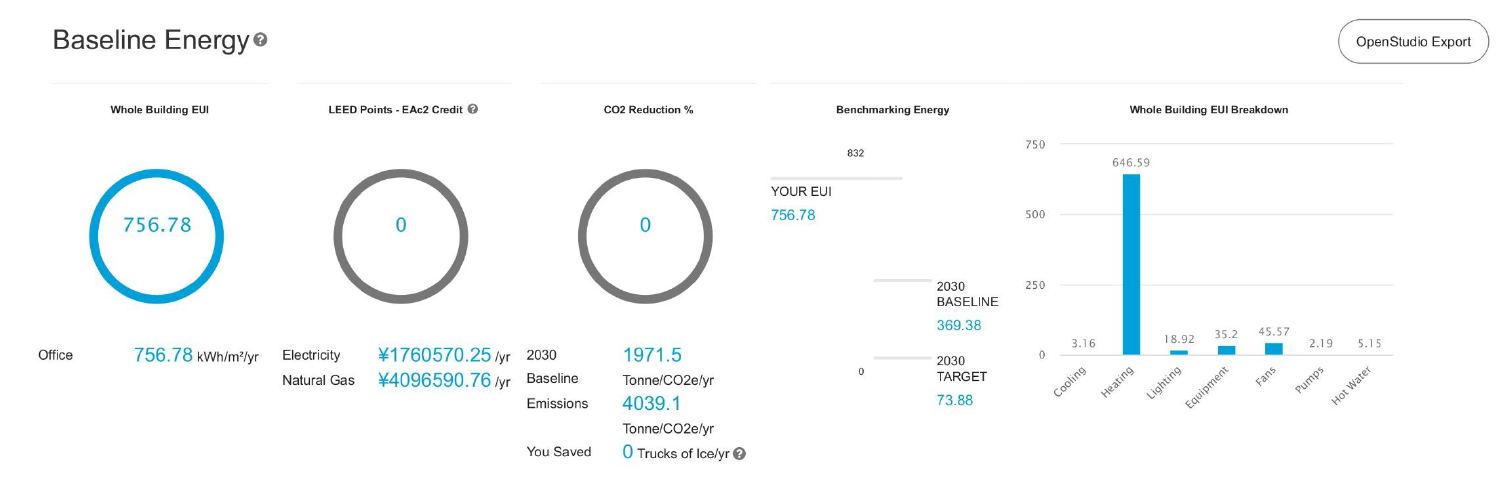
Figure A40. Zone 7 Harbin, Heilongjiang (pre-COVID-19 scenario).